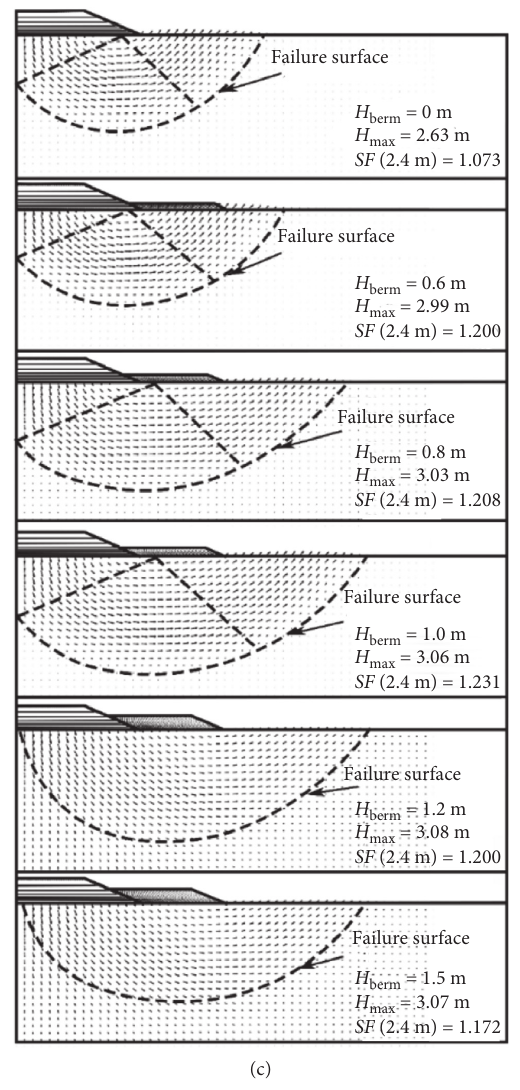
Figure 9: Effect of height of berms: (a) effect on limiting stack height; (b) effect on safety factor; (c) soil heaving mechanism with global failure mechanism; (d) soil heaving mechanism with local failure mechanism.